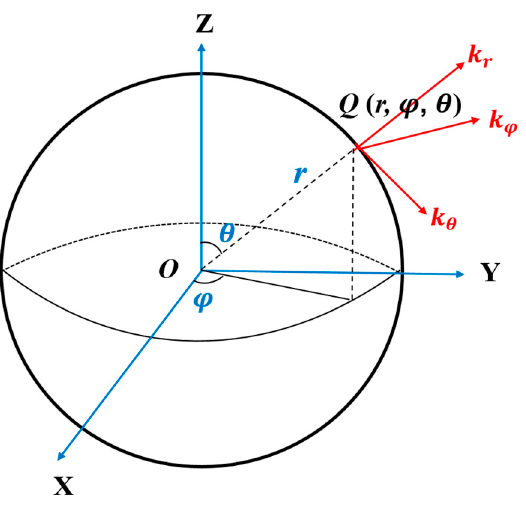
Figure 1. Schematic diagram of ray tracing spatial coordinates.